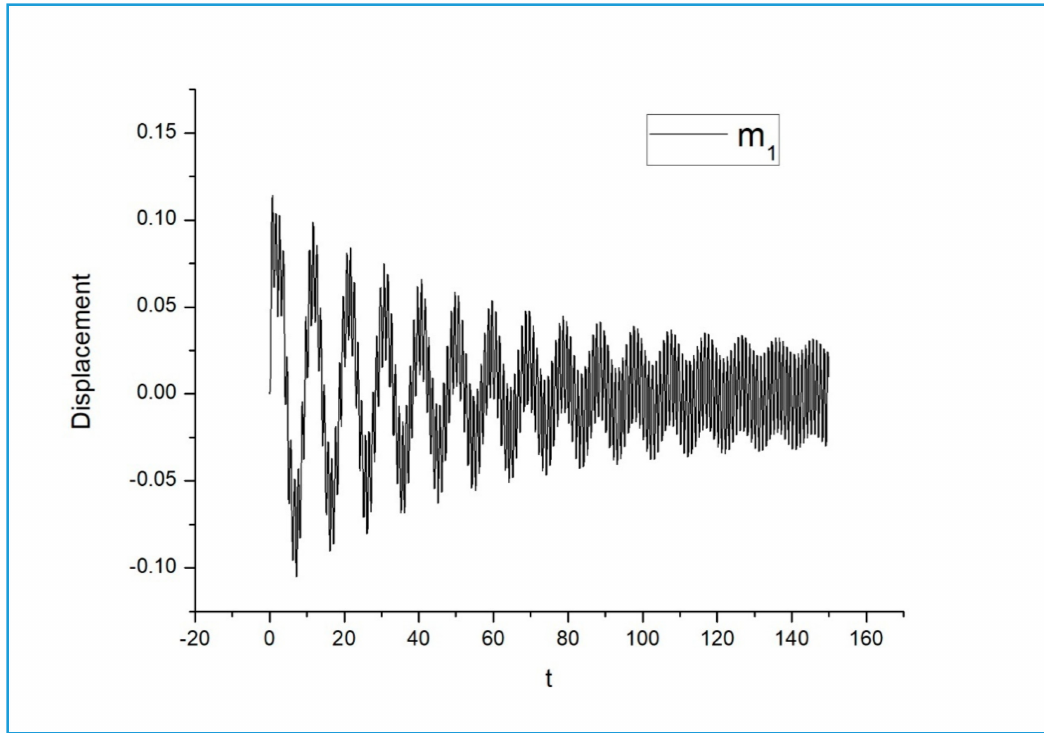
Figure 15. Displacement for m 1